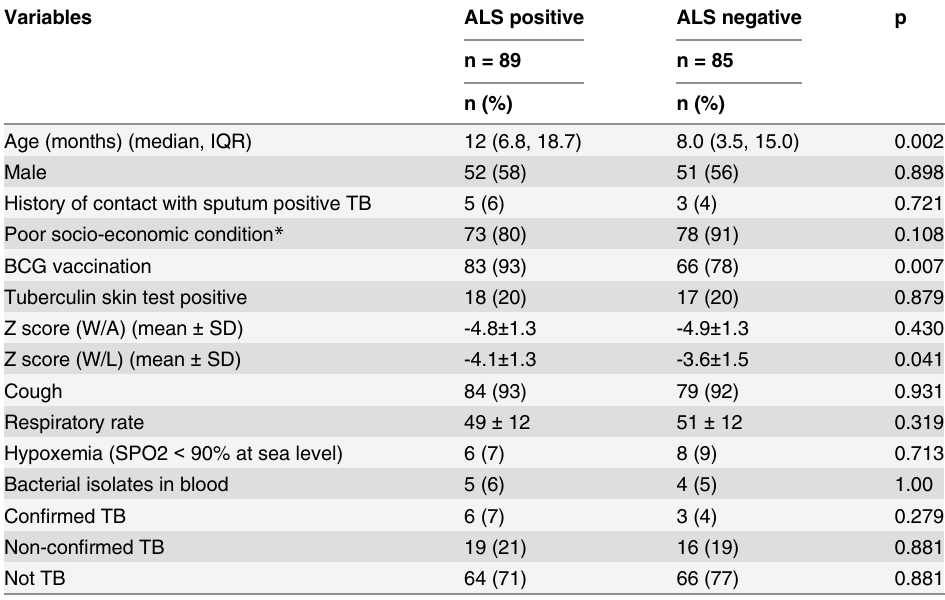
Table 2. Characteristics of severely malnourished children with suspected pneumonia who had their ALS done.